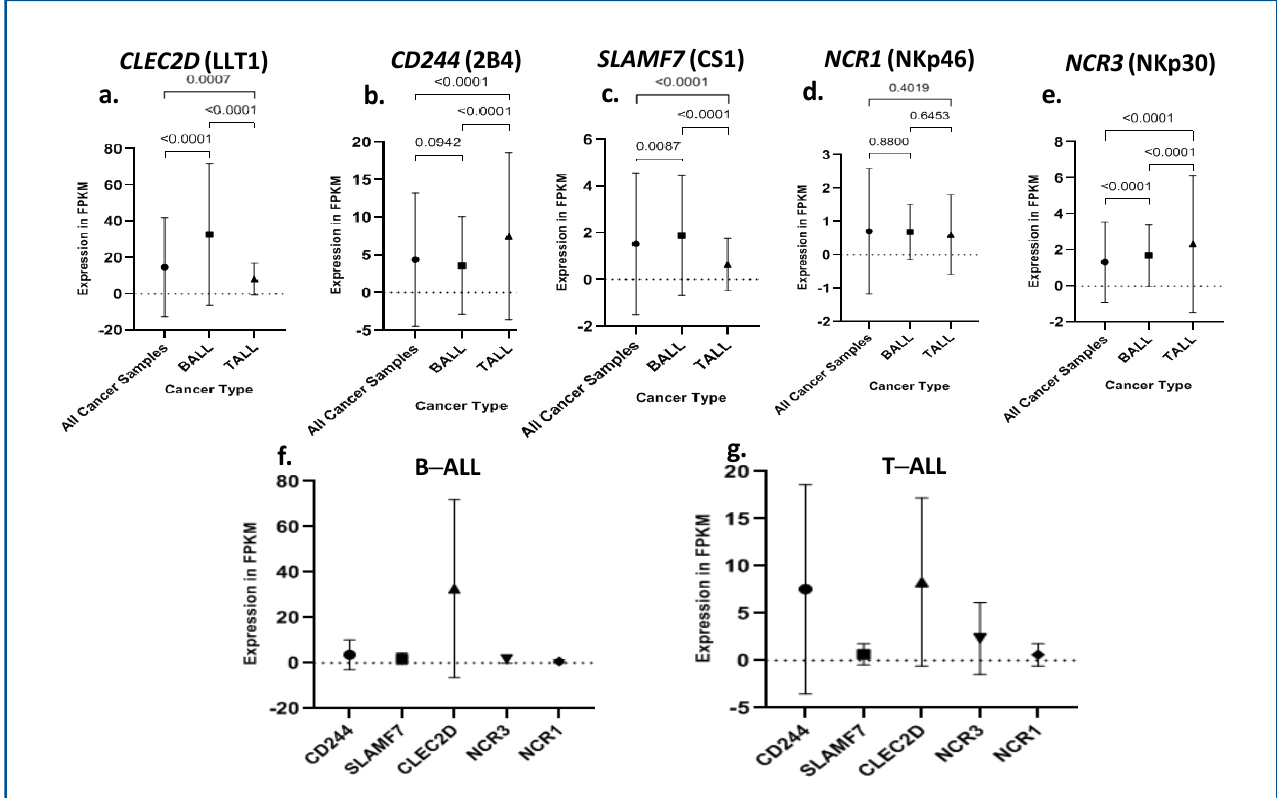
Figure 1. RNA–seq expression in ALL subtypes and other pediatric cancers. ( a – e ) Expression of each of the receptors in B–ALL and T–ALL subjects in comparison with all other pediatric cancers. ( f ) Comparison of expression of LLT1, 2B4, CS1, NKp46 and NKp30 in B–ALL subjects. ( g ) Comparison of expression of LLT1, 2B4, CS1, NKp46 and NKp30 in in T–ALL subjects.